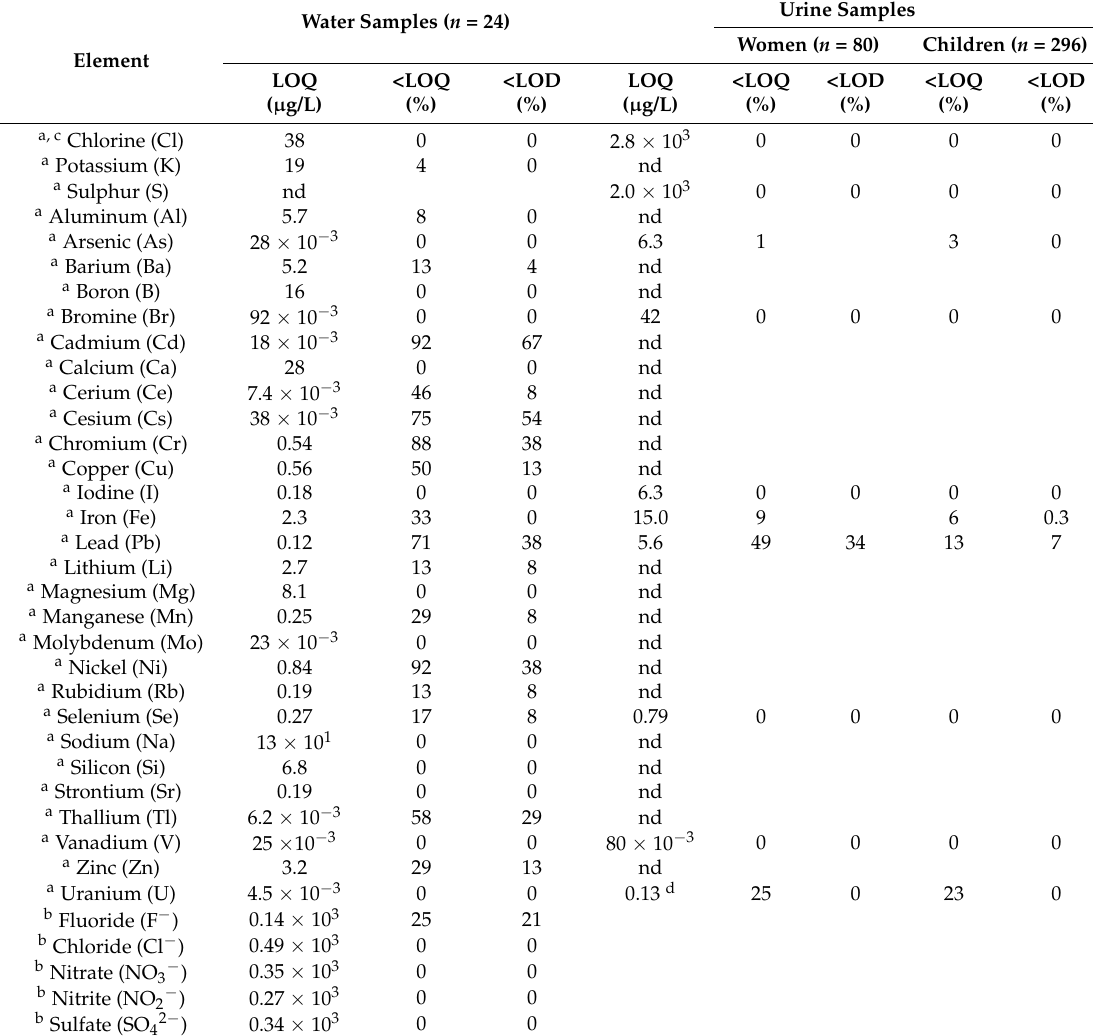
Table 2. Limit of quantification (LOQ) for all elements and anions in drinking water and urine. Percentage of samples with unquantifiable (<LOQ) and undetectable (<LOD) element concentrations in water, and in urine among women and children,